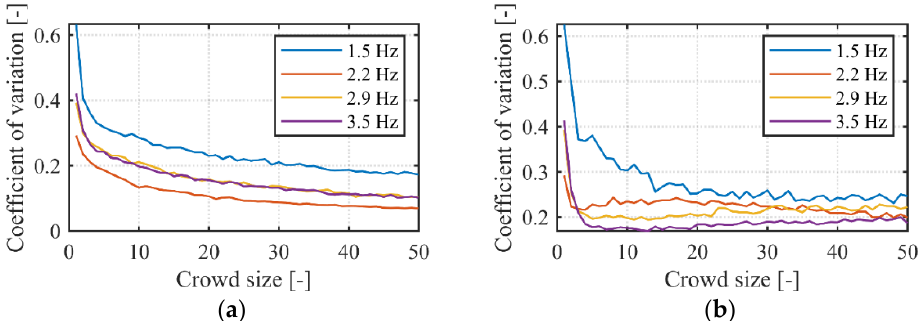
Figure 10. Modeling of the coefficient of variation of different guidance frequencies. ( a ) Modeling for the first harmonic, ( b ) Modeling for the second harmonic.